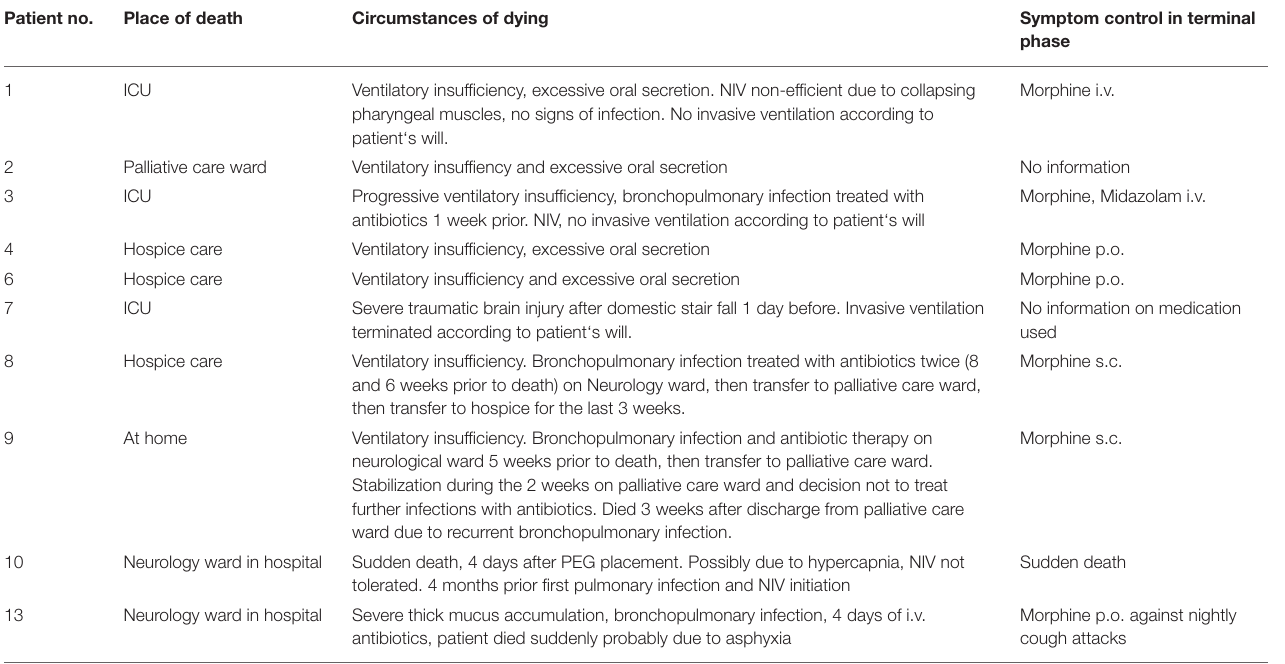
TABLE 2 | Terminal phase of PBP patients. Patient